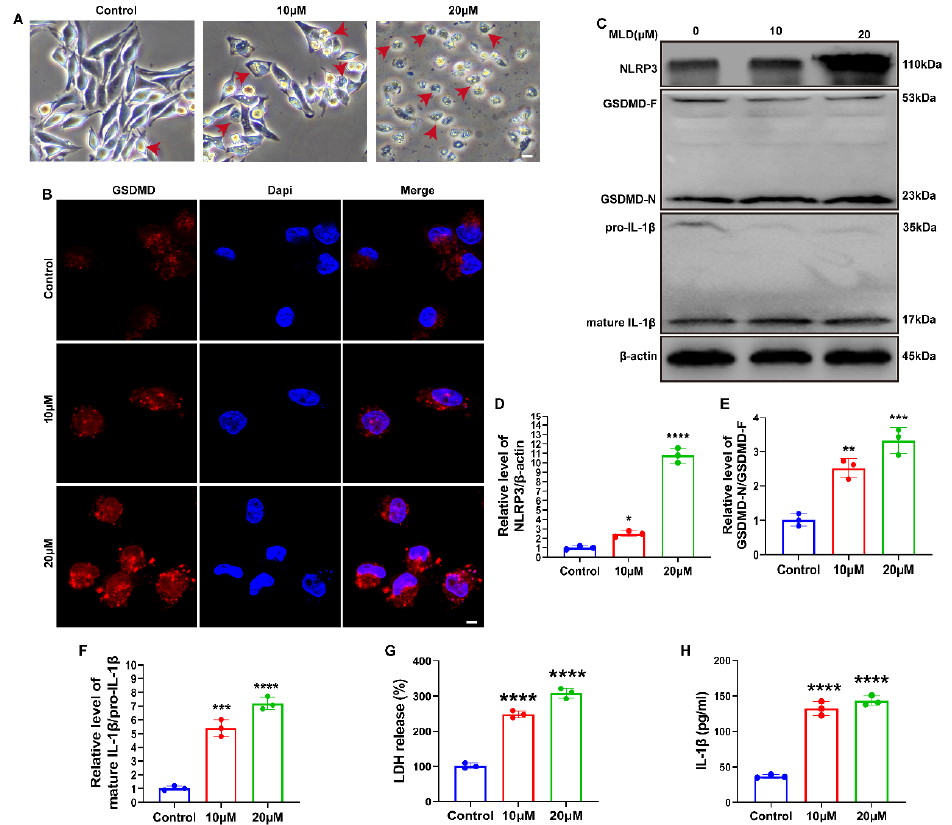
Figure 4. MLD promoted HepG2 cell death via activating GSDMD-mediated pyroptosis. ( A ) The morphological changes of HepG2 cells treated with MLD. Scale bar: 100 µ m. Arrow: the